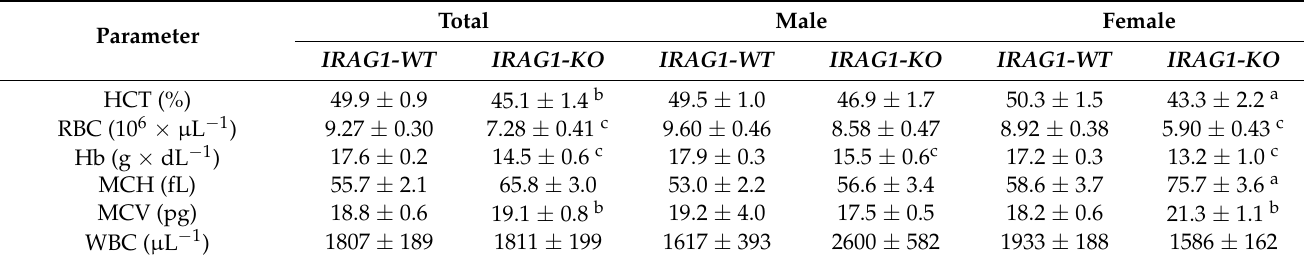
Figure 2. Analysis of spleen and body weight of IRAG1-WT and IRAG1-KO mice. ( A ) Increased spleen weights in IRAG1-KO (total: n = 32; female: n = 16) mice compared to their WT littermates (total: n = 40; female: n = 16) were determined, but not in male IRAG1-KO ( n = 16) and IRAG1-WT mice ( n = 24). ( B ) No differences in the body weights of IRAG1-KO mice (total: n = 32; male: n = 16; female: n = 16) and their WT littermates (total: n = 40; male: n = 24; female: n = 16) were found. ( C ) Spleen-weight-to-body-weight ratios of IRAG1-KO mice (total: n = 32; female: n = 16) were increased compared to their WT littermates (total: n = 40; female: n = 16), but not in male IRAG1-KO ( n = 16) and IRAG1-WT mice ( n = 24). Circles indicate the individual value of each mouse and mean ± SEM is shown by bars. Significant differences are shown by (***) ( p < 0.001). Table 2. Hematological parameters of IRAG1-WT and IRAG1-KO